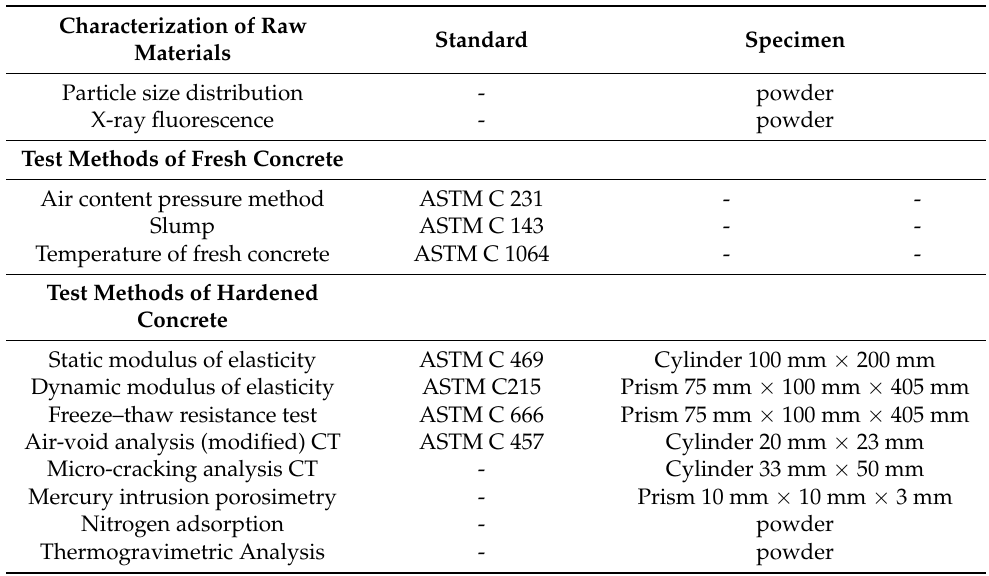
Table 4. Testing methods and